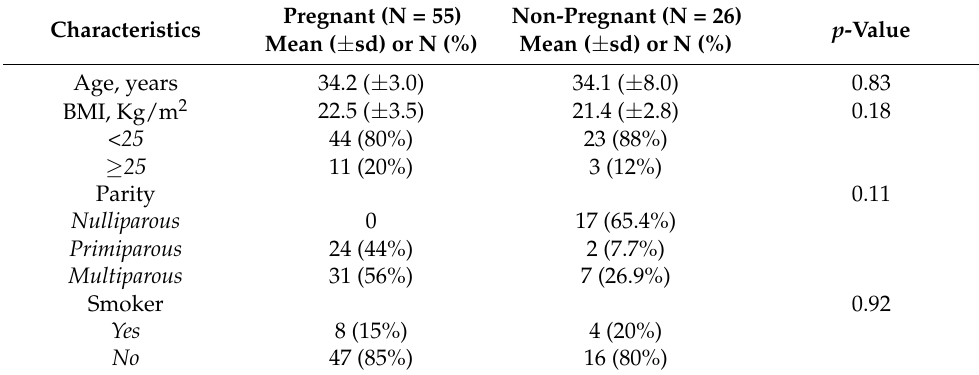
Table 1. Characteristics of the study participants.